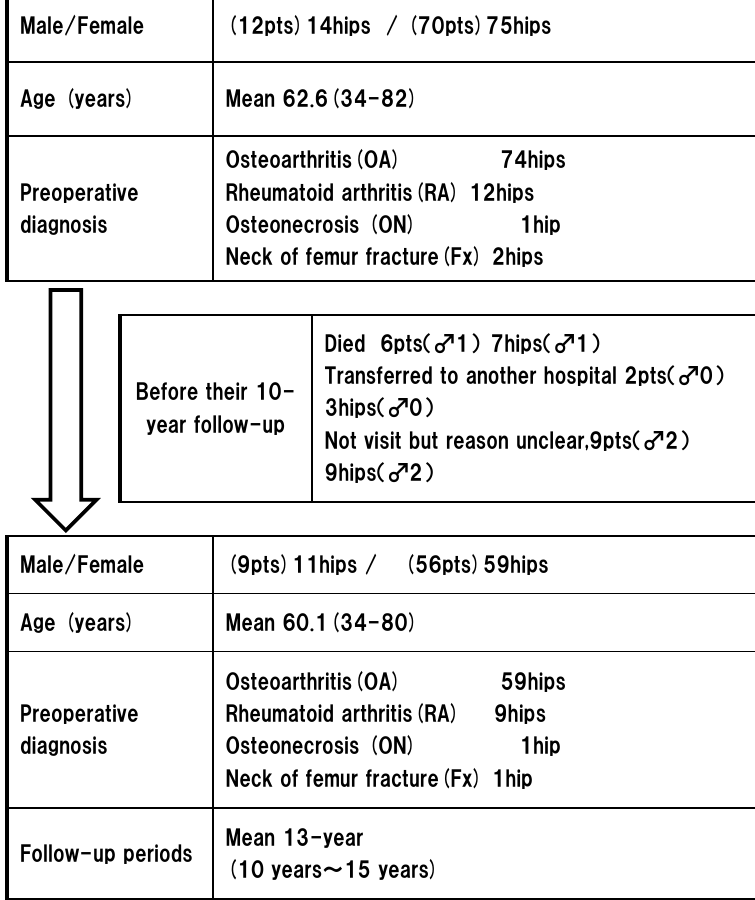
Figure 1. Study flow chart of patient selection and demographic background.